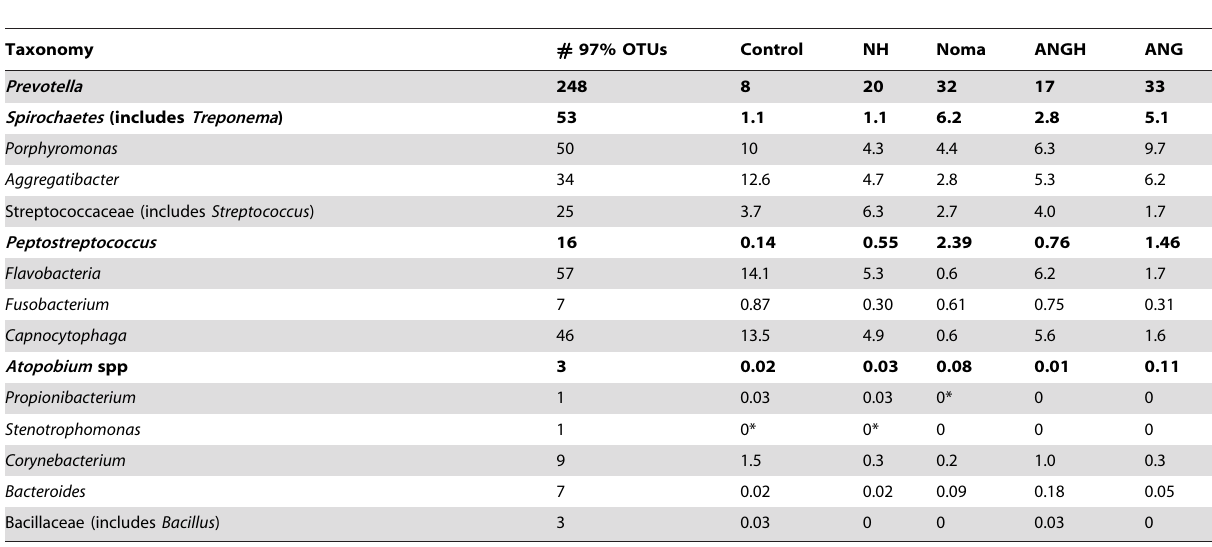
Table 3. Percentage of reads that correspond to bacterial groups suspected of triggering noma in the different sample groups, as determined by OTUs from the 97%